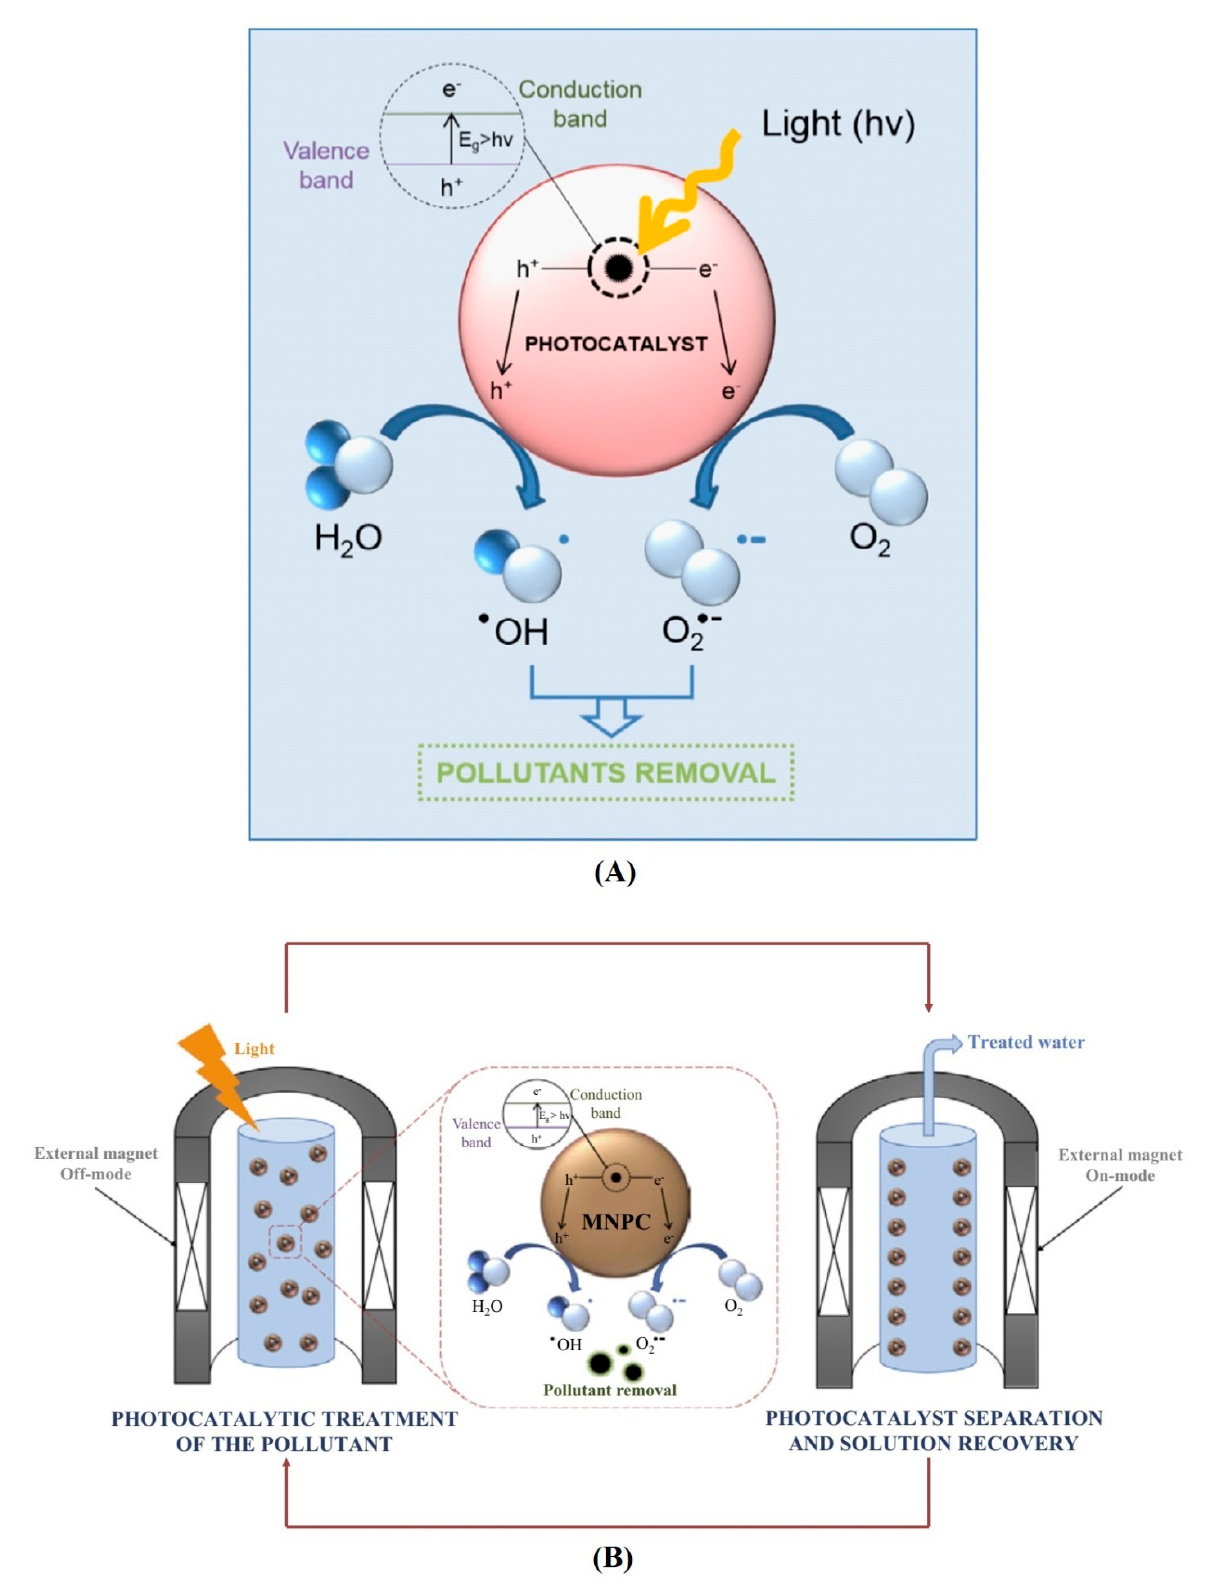
Figure 4. Graphical representation of ( A ) excitation of a nanophotocatalyst during the photocatalytic process; ( B ) photocatalytic treatment of polluted water and recovery of nanophotocatalyst (Reproduced with permission from [130]).